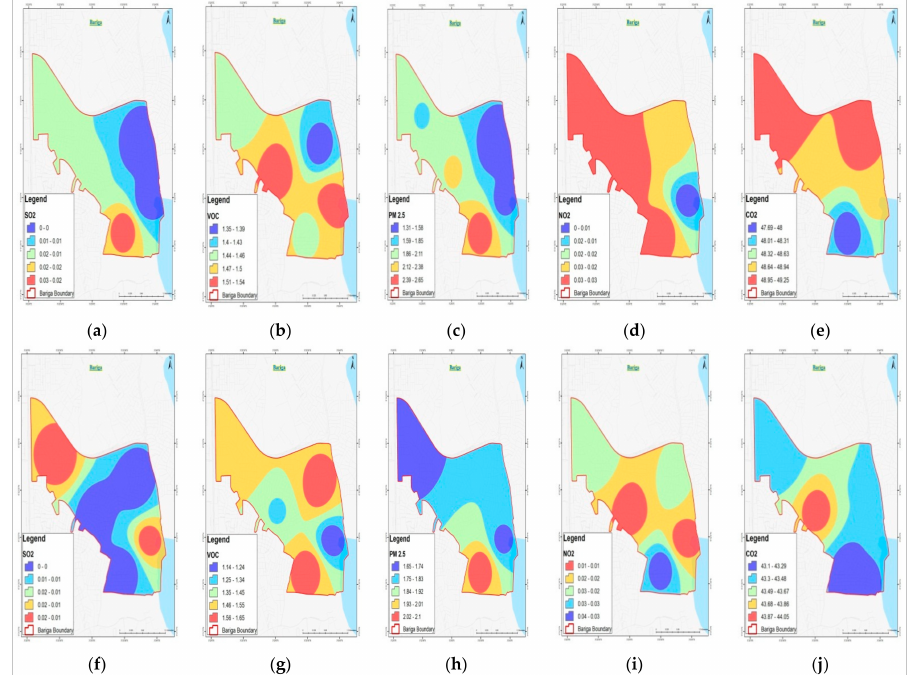
Figure 5. Air pollutant concentration maps showing the dispersal pattern of pollutants in the Bariga slum settlement, including areas with high and cold spot zones, identified by four color types on the map, from the 2018 to 2019 sampling period. ( a ) SO 2 mg/m 3 Dry; ( b ) VOC mg/m 3 Dry; ( c ) PM 2.5 µ g/m 3 Dry; ( d ) NO 2 mg/m 3 Dry; ( e ) CO 2 mg/m 3 Dry; ( f ) SO 2 mg/m 3 Wet; ( g ) VOC mg/m 3 Wet; ( h ) PM 2.5 µ g/m 3 Wet; ( i ) NO 2 mg/m 3 Wet; ( j ) CO 2 mg/m 3